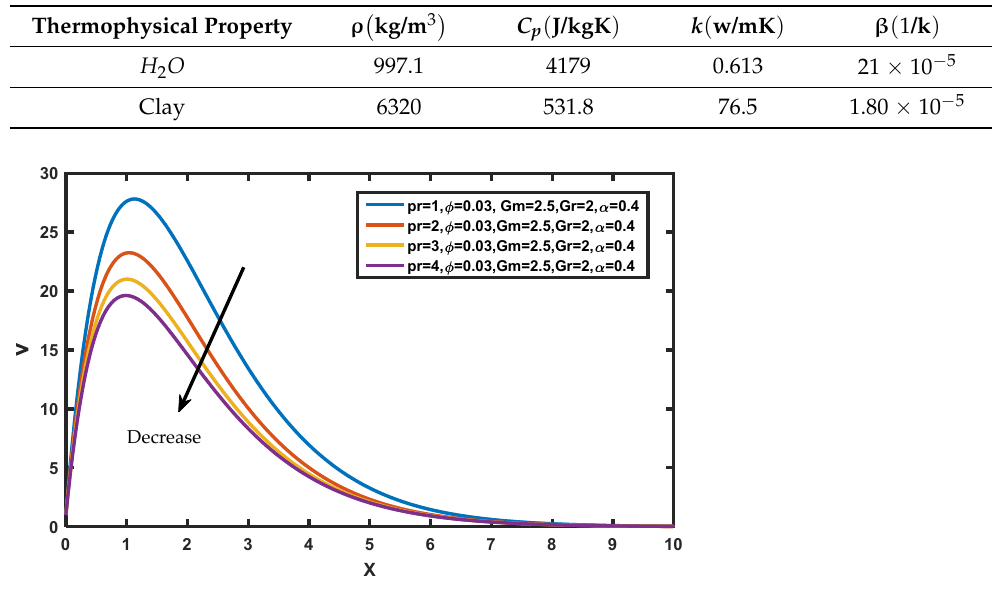
Figure 2. Variation of Pr in v .